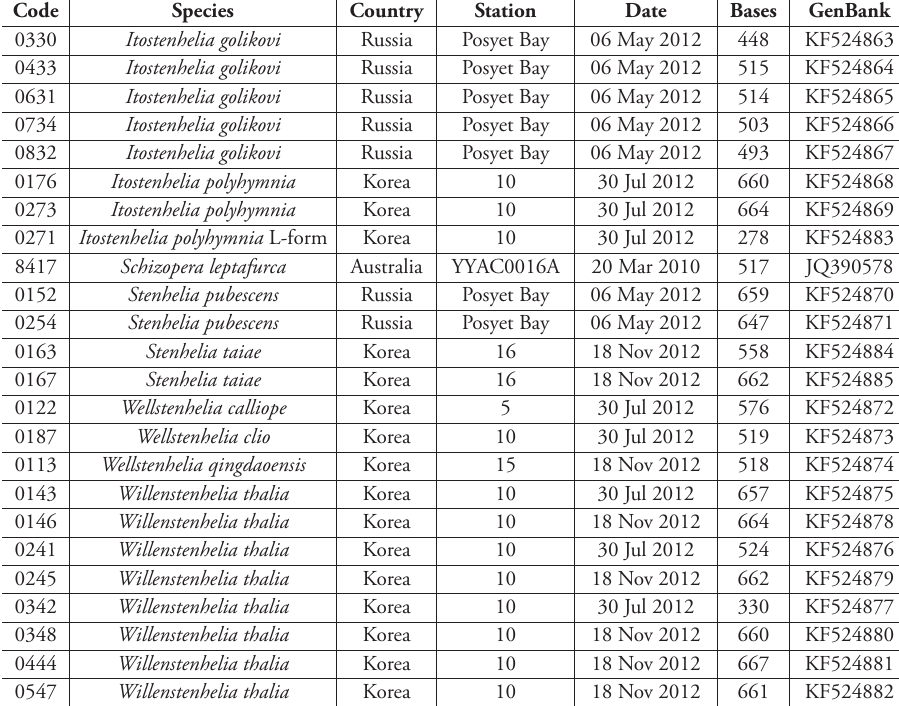
Table 2. List of copepod specimens for which mtCOI fragment was successfully amplified.